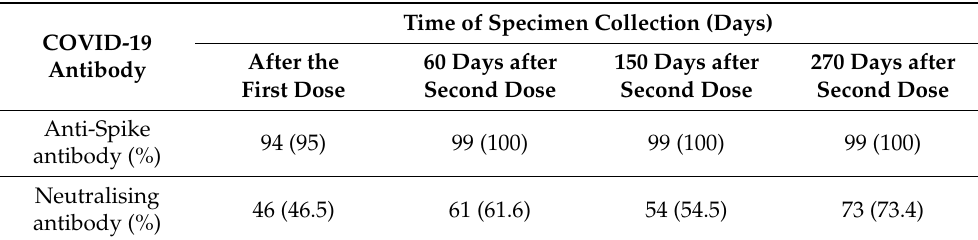
Table 5. Proportion of participants, without anti-spike antibody before vaccination, who developed COVID-19 antibody after vaccination ( n = 99).